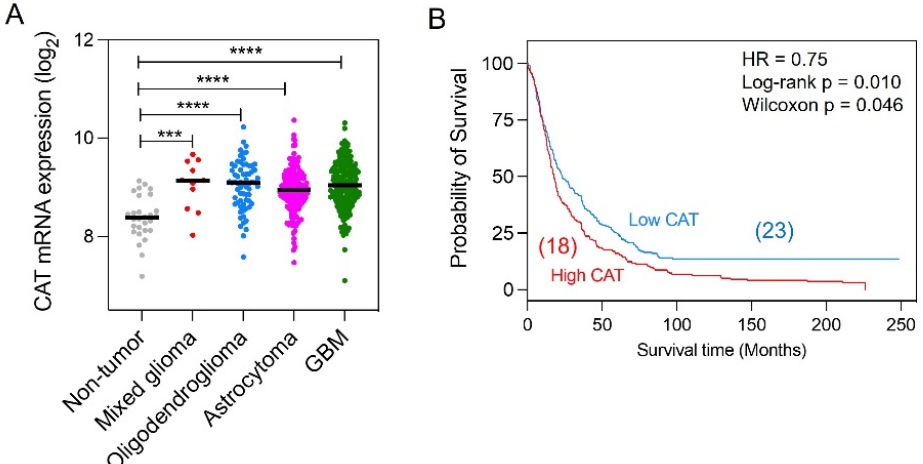
Figure 1. Expression of CAT mRNA in human glioma. ( A ) Expression of CAT mRNA in glioma tissue and non-tumor brain tissue samples from the Rembrandt dataset. Median values are represented as lines in the scatter plot. *** p < 0.001, **** p < 0.0001 by ANOVA. ( B ) Kaplan-Meier survival curves of overall survival in patients with glioma stratified by CAT mRNA expression levels in tumors (low CAT, n = 208; high CAT, n = 189). Numbers between brackets indicate median survival time. CAT, catalase.